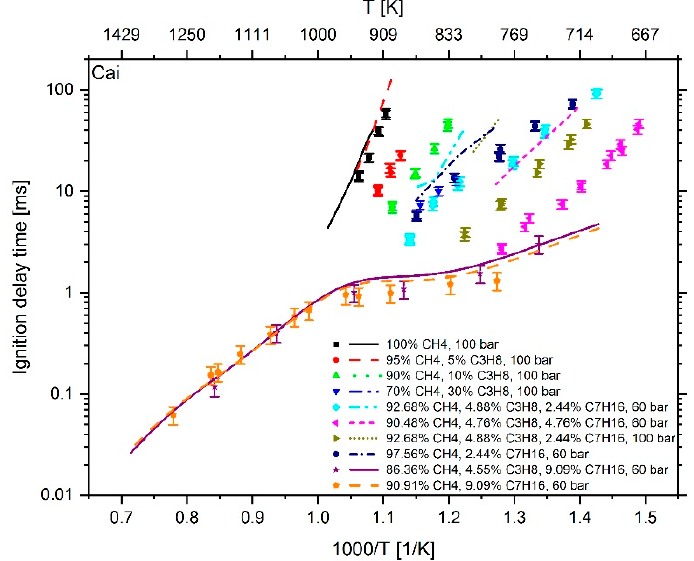
Figure 4. Experimental data (symbols) [6,7] versus model prediction (lines) using the mechanism of Cai et al. [24].